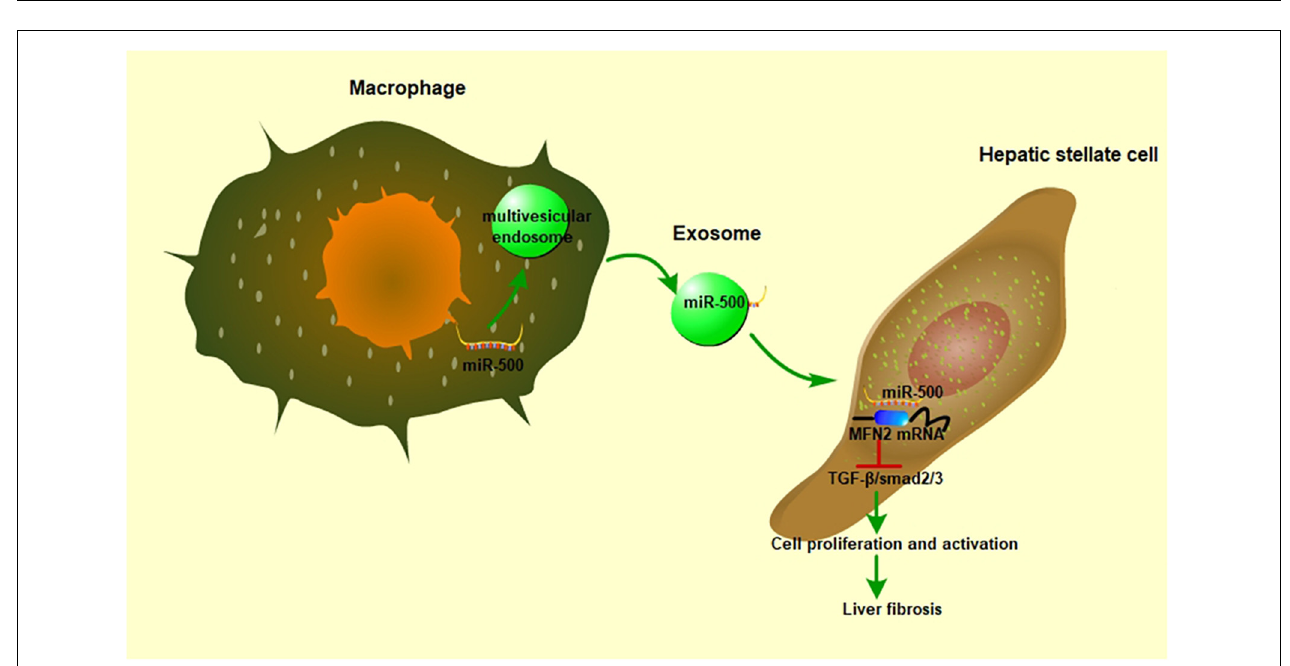
FIGURE 8 | The role of exosomal miR-500 in the communication between macrophages and HSCs. In LPS-treated macrophages, miR-500 was highly expressed and then included into the multivesicular endosomes, which were secreted into intercellular space. After these exosomes being uptaken by recipient cells, the miR-500 in exosomes would inhibit the expression MFN2 by binding with its 3 (cid:48) UTR, consequently promoting the proliferation and activation of HSC via TGF- β /Smad signaling pathway and accelerating liver